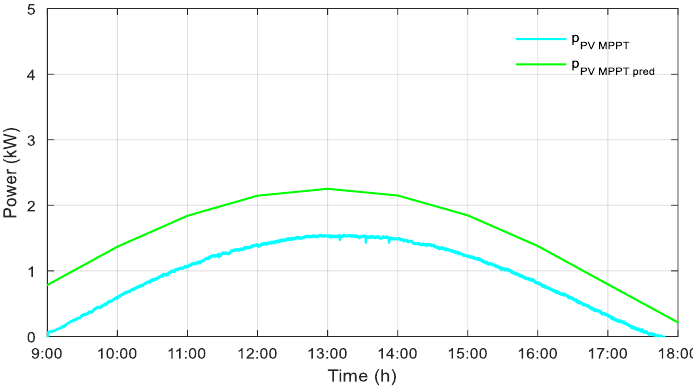
Figure 19. PV MPPT real and predicted powers and IIREV demand power — experimental test 1.